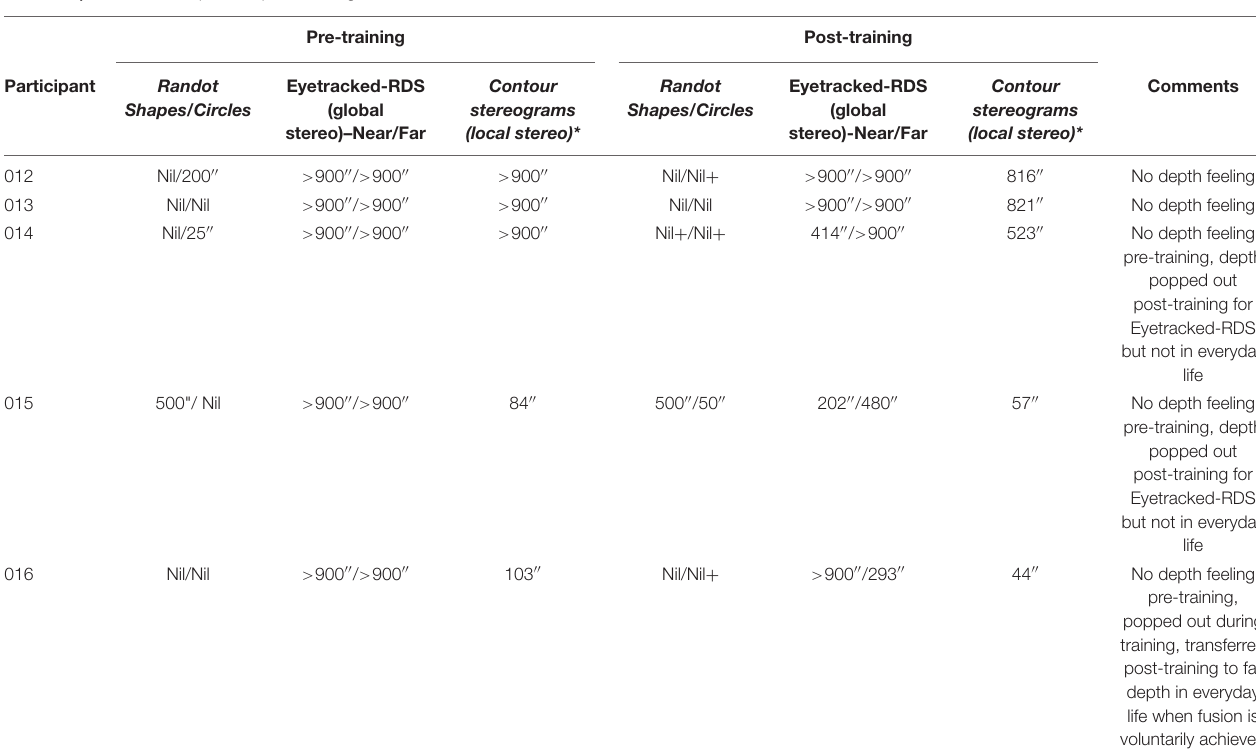
TABLE 2 | Stereoacuities pre and